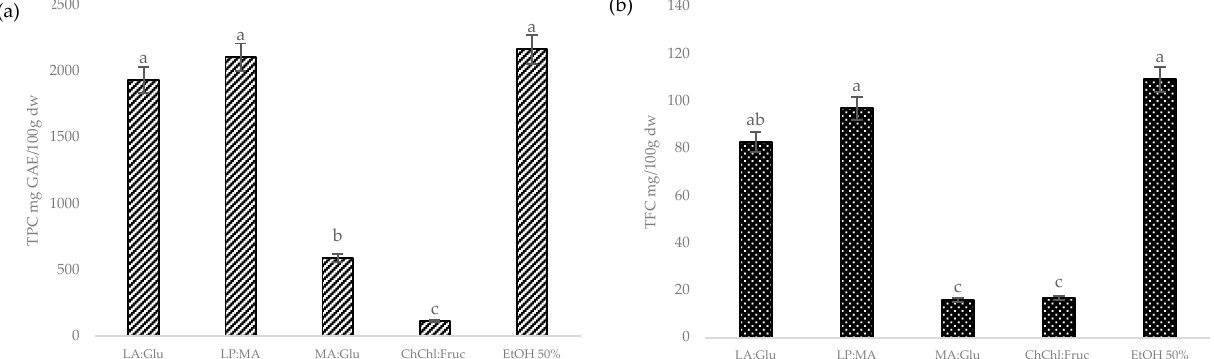
Figure 2. Model validation. ( a ) Total polyphenol content (mg GAE/100 gdw), ( b ) total flavonoid content (mg/100 gdw). Results are expressed as the means ( n = 3) ± DS. Different lowercase letters (a–c) are significantly different ( p < 0.05) as measured by Tukey’s test.